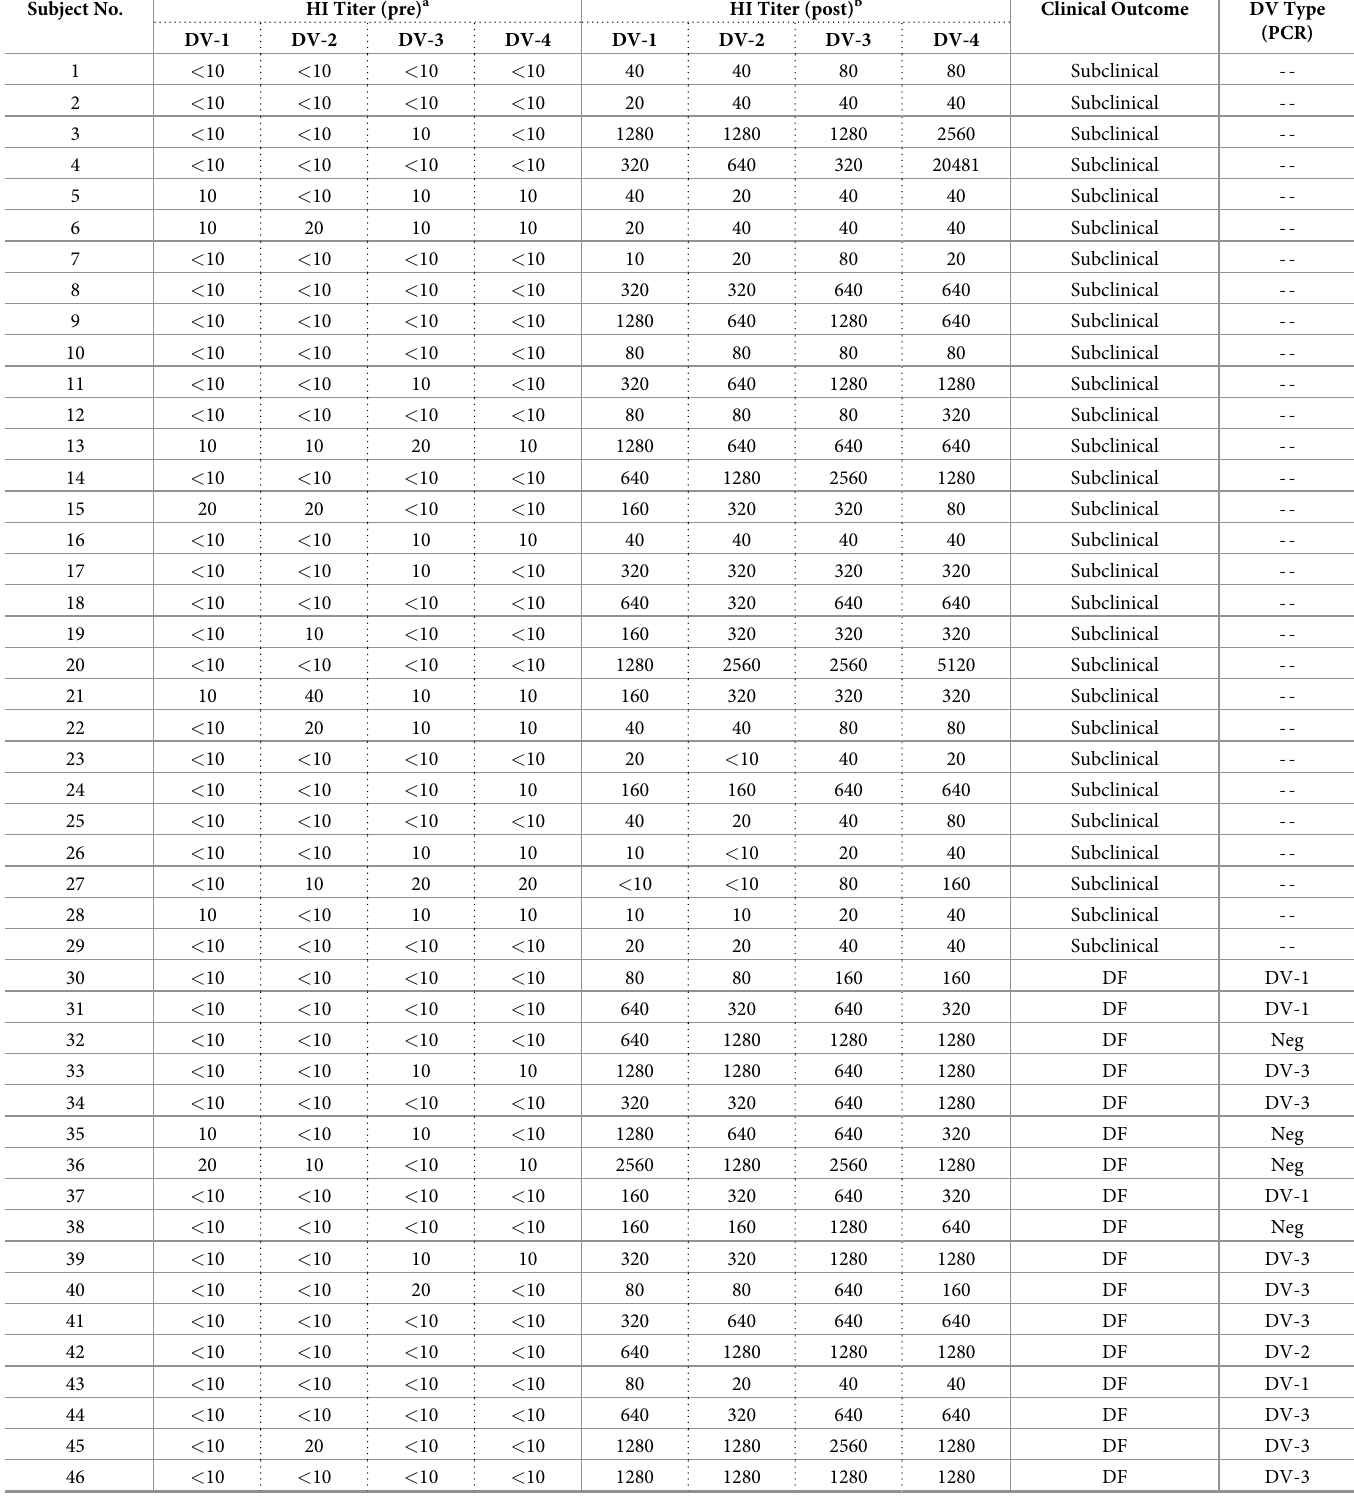
Table 1. Characteristics of the study